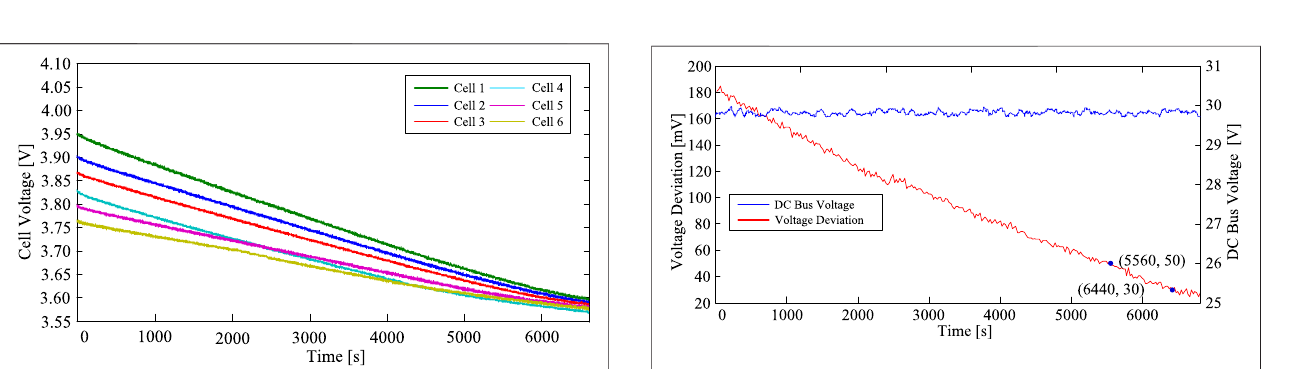
FIGURE12| VoltagedeviationofsixcellsandDCbusvoltageduringthe discharging process with a static acceleration coef fi cient.